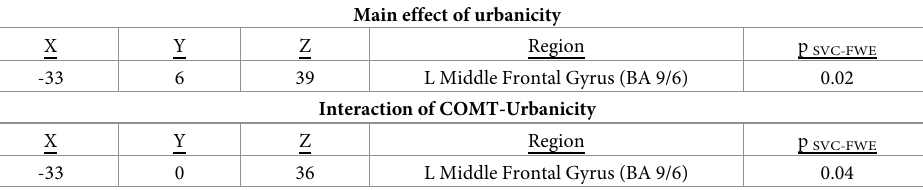
Table 3. Main effect of urbanicity and COMT-urbanicity interaction: US replication (n =